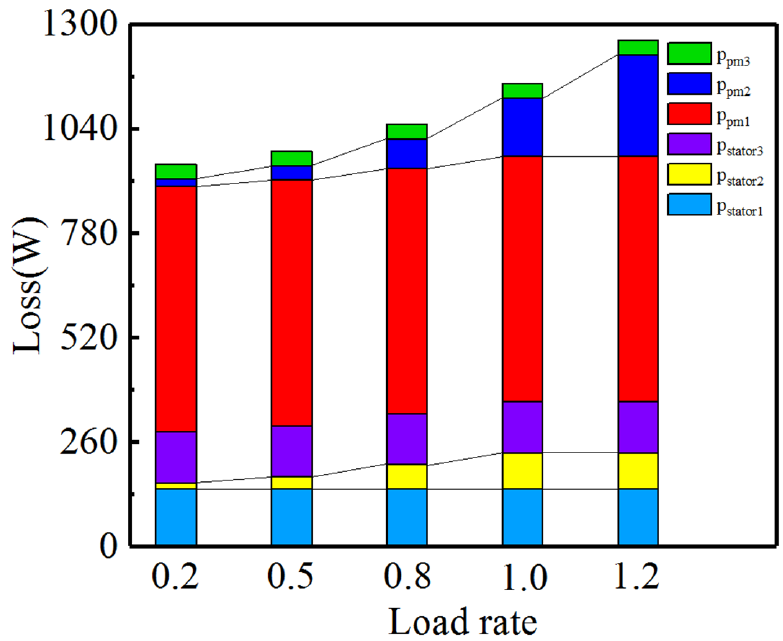
Figure 13. Loss separation of FeCo motors with different load rates.